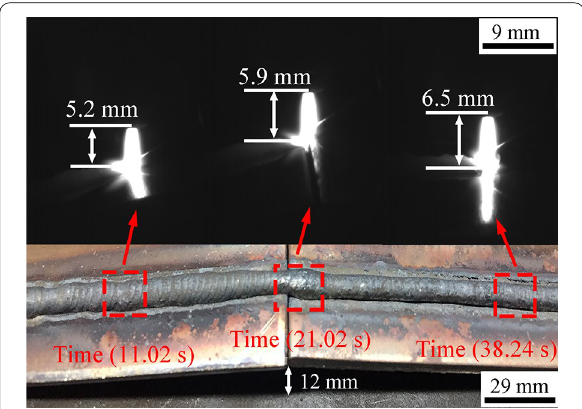
Figure 14 Changes in torch stand-off distance during sloping-substrate test